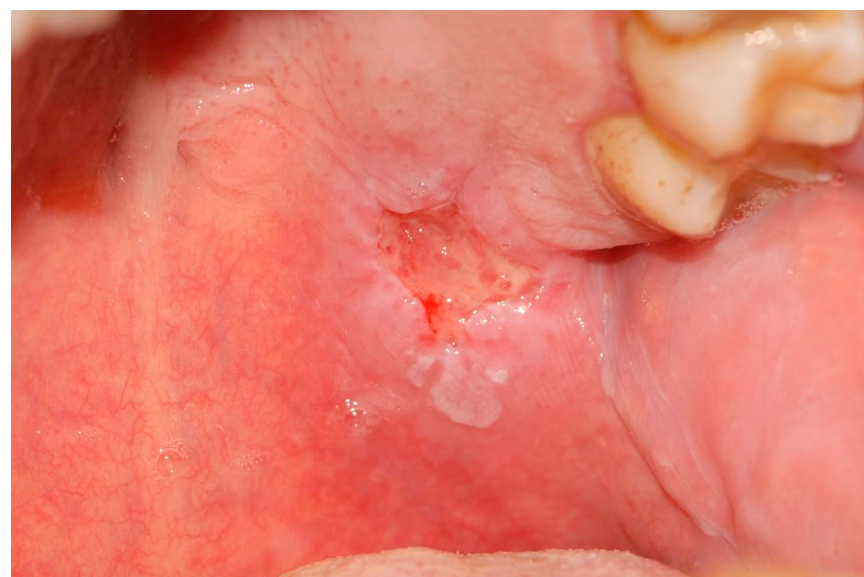
Figure 5. Ulcerative lesion of the hard palate (Patient no. 13, Table 2).